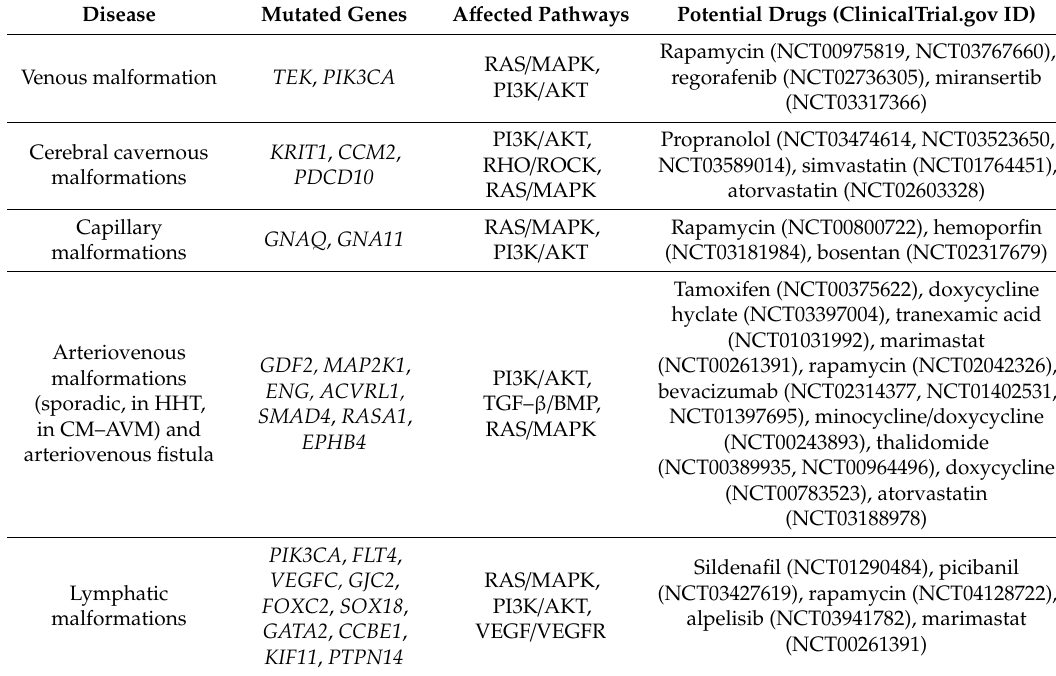
Table 3. Possible pharmacological treatments for vascular